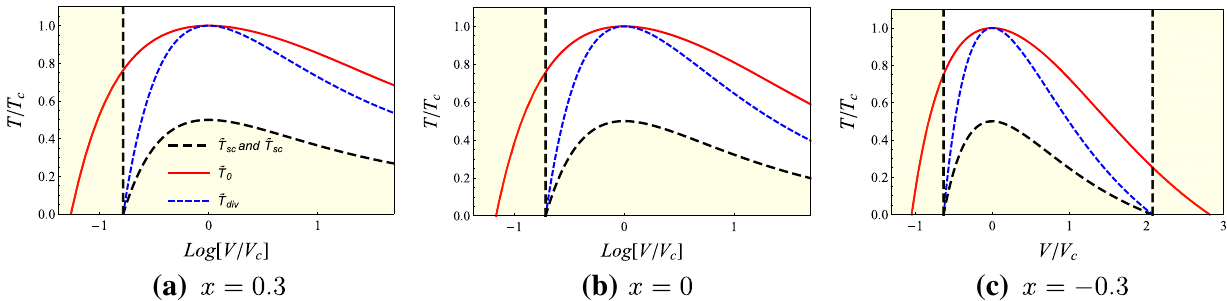
Fig. 6 Characteristic curves of the normalized scalar curvature. The red solid curve is the coexistence curve, and the black and blue dashed curves correspond to the sign-changing curve and divergence curve, respectively. The region painted in yellow represent that R N > 0